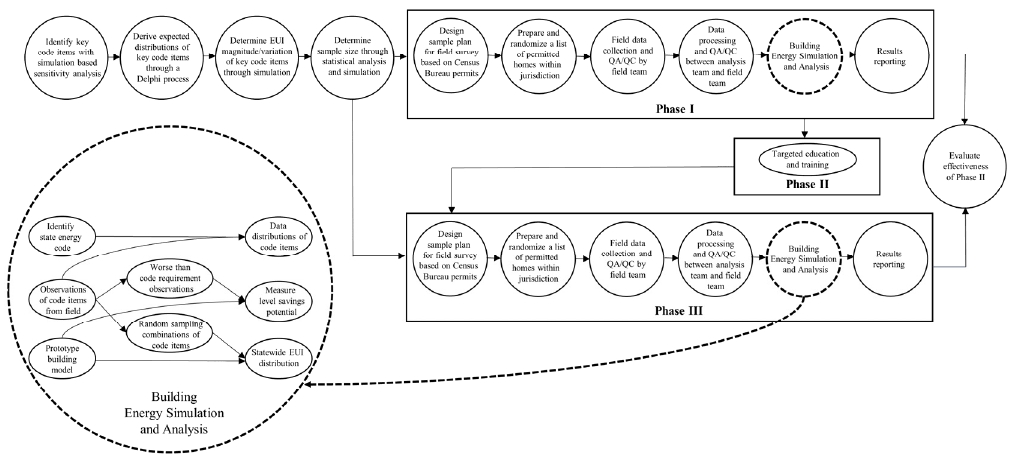
Figure 1. Methodology